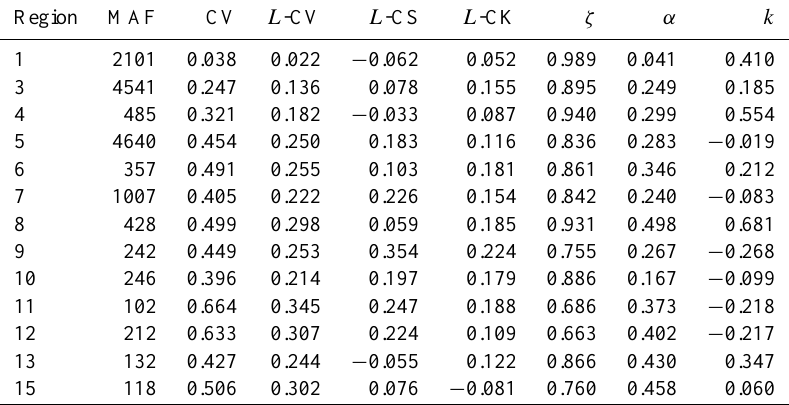
Table 3. The average record length, the number of gauged catchments, regional homogeneity test results, catchment characteristics used in the regression for the MAF, the NME in estimating the MAF and the NMSE of the CV of the AMF per region.